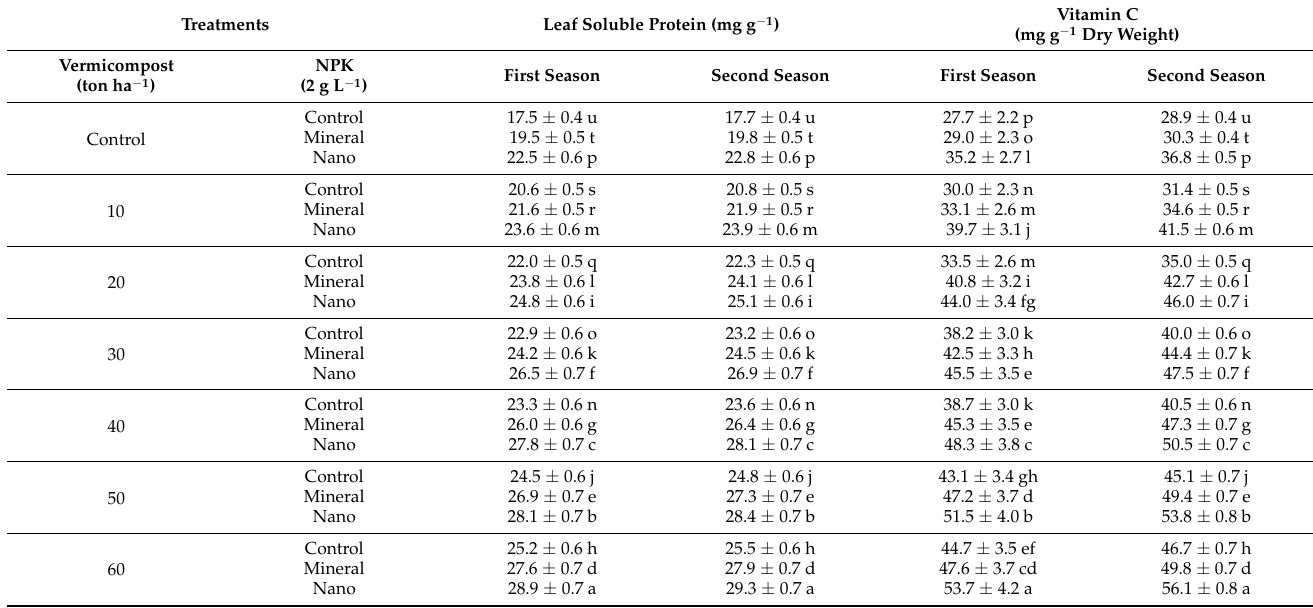
Table 7. The influence of combined treatments of vermicompost and NPK fertilization on the mean values of leaf soluble protein (mg g − 1 ) and vitamin C (mg g − 1 dry weight) of Moringa oleifera trees in the first and second seasons.